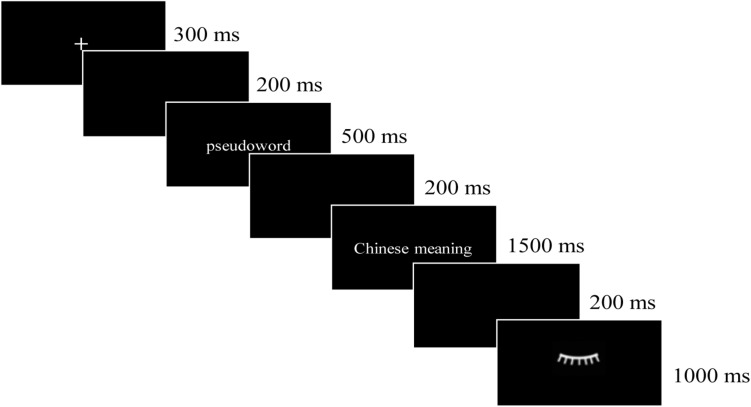
The procedure of learning.